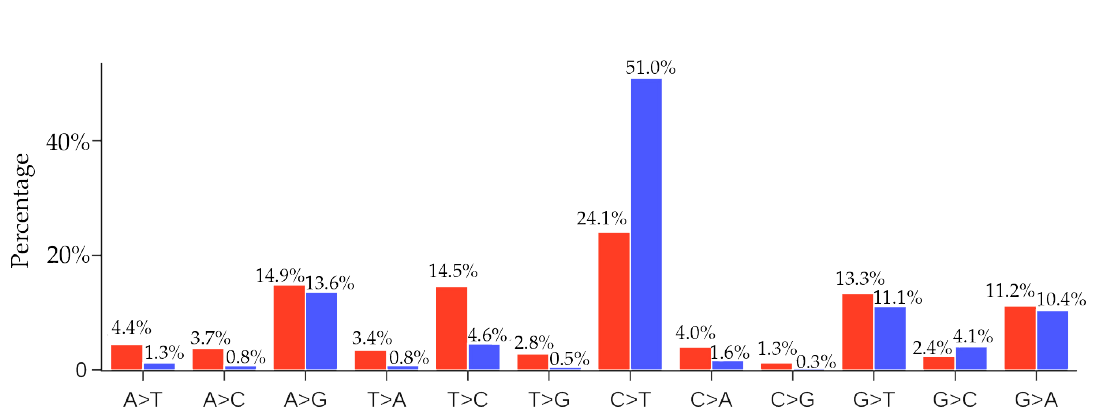
Figure 11. Comparison of the ratios of 12 SNP types among unique mutations (red) and non-unique mutations (blue) in SARS-CoV-2 genomes globally. Here, if we count the same mutation that appears in different SARS-CoV-2 isolates only once, we call those mutations unique mutations. If we count the same mutation in different SARS-CoV-2 isolates repeatedly according to their frequency, then all of the mutations that are detected in the complete SARS-CoV-2 genome sequences are called non-unique